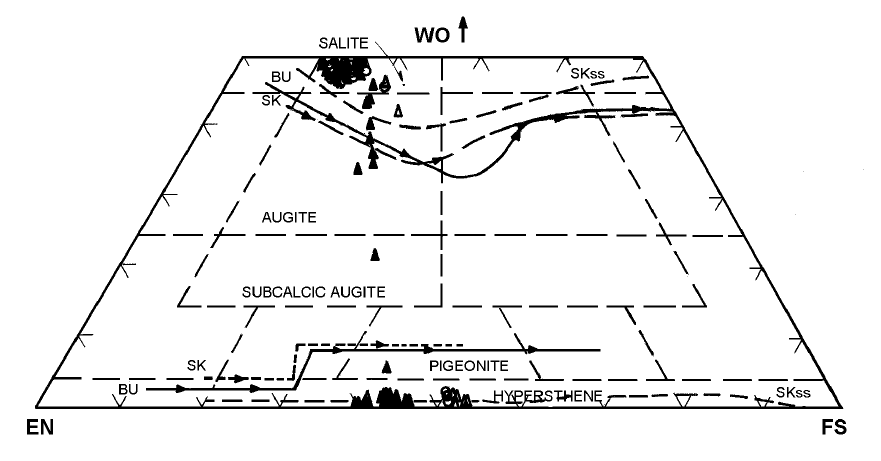
Fig. 13 – Variation of compositions from both pyroxene grains and exsolution lamellae reveals a narrow interrupted sub-solidus tholeiitic trend close to the sub-solidus trend of Skaergaard (Skss) CPX-crystals (Deer et al. 1978). A second trend varies from the salite towards the pigeonite field, along a tie-line of the diagram (see text for explanation). The analysis of OPX crystals and CPX exsolution lamellae, from the same rock sample, reveals compositions along a sub-solidus trend as